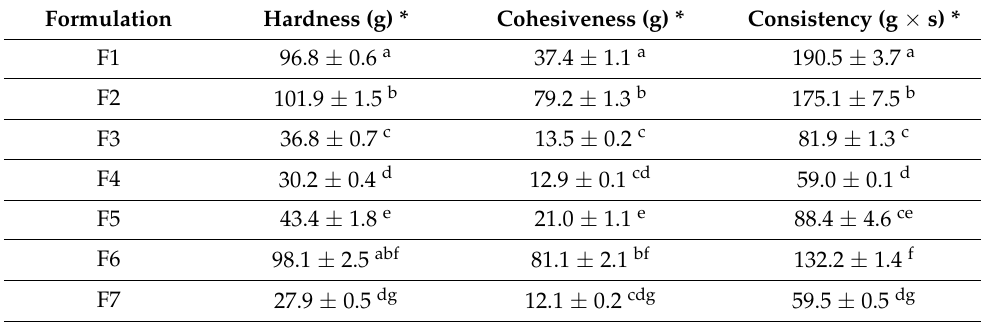
Table 4. Textural properties of gel formulations (mean ± SD, n = 6).